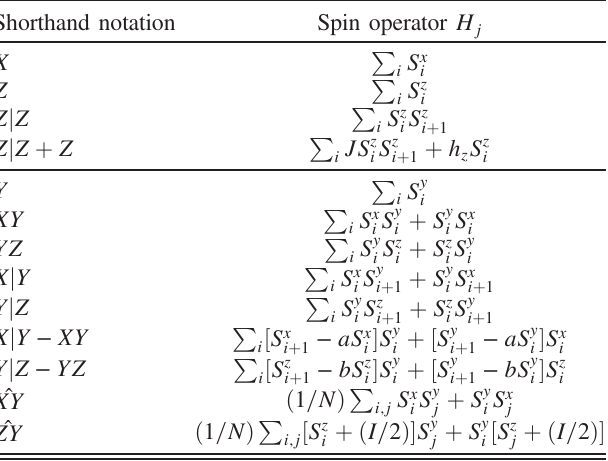
TABLE I. Shorthand notation for the generators H j used to The j indicates operators acting on neighboring sites. Terms from the variational gauge potential series are shown in the lower group (cf. Appendix E for the